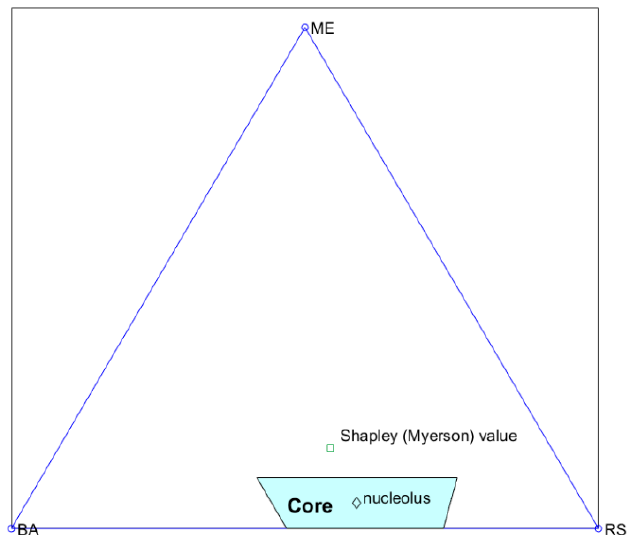
Figure 3. The core, Shapley (Myerson) value and nucleolus of the 3-country game. Table 2. Data and characteristic values for the 3-country game (in MW).